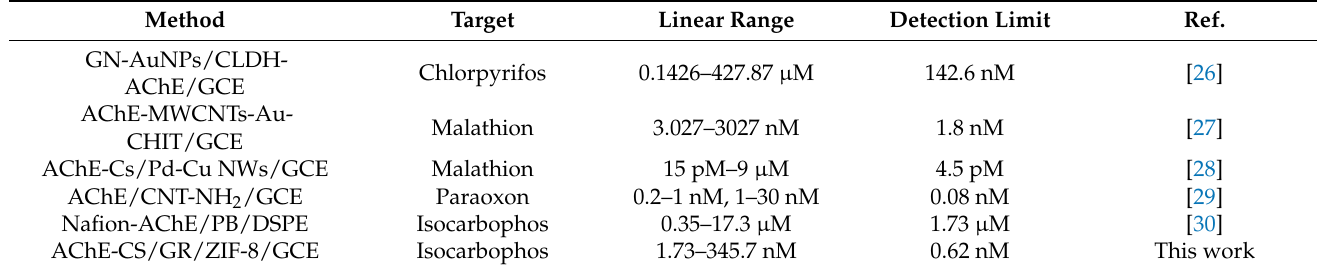
Table 1. Comparison of the performance of some other reported AChE sensors for the detection of